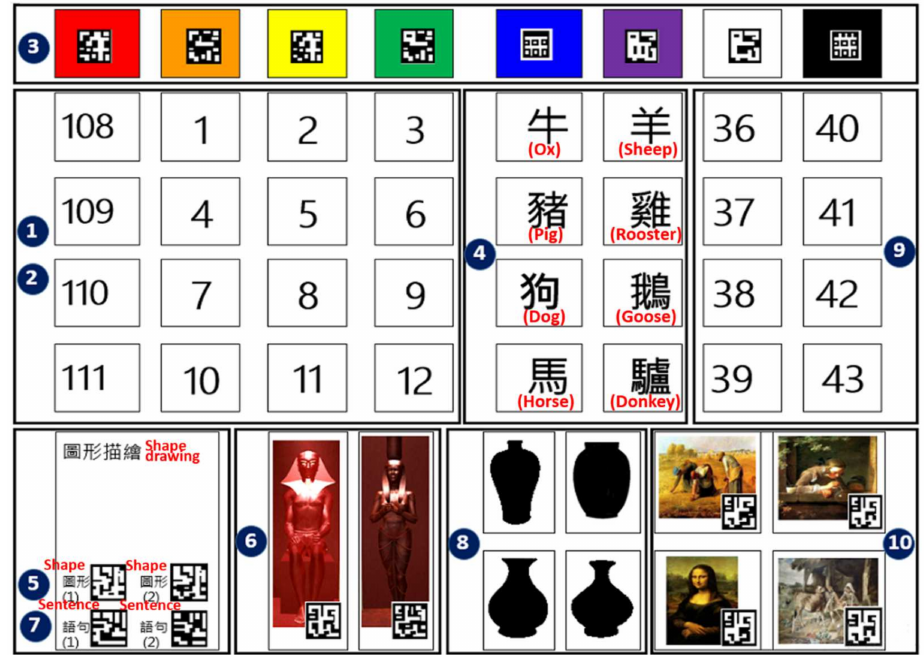
Figure 2. Cognitive board for the subject to answer